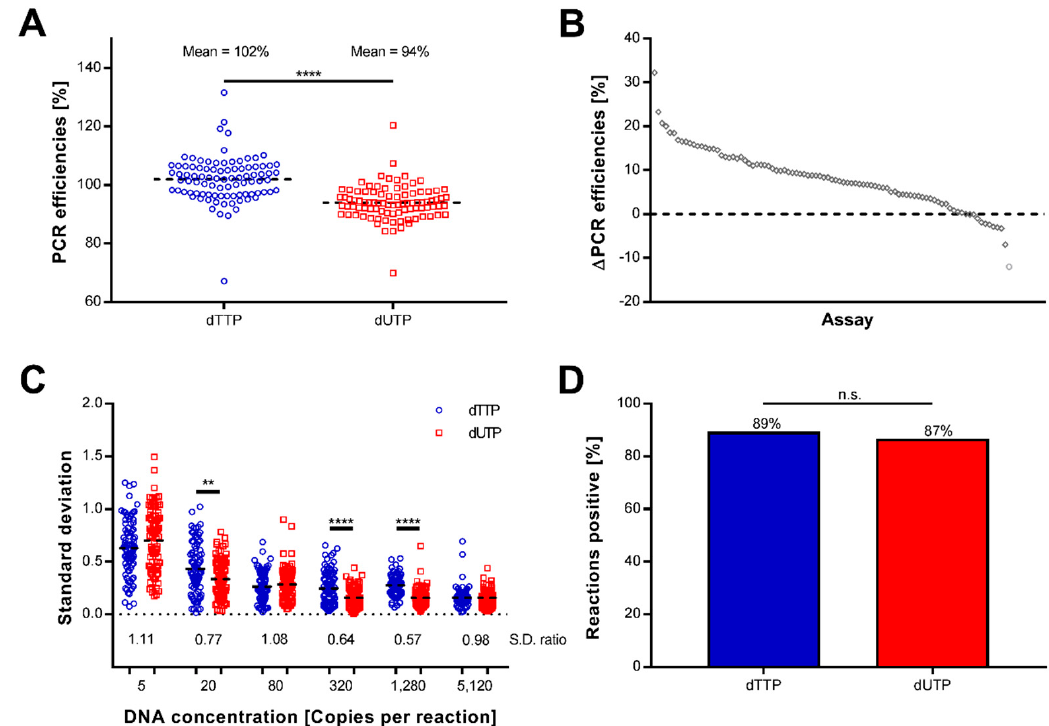
Figure 2. Targeted preamplification with deoxythymidine triphosphate (dTTP) and deoxyuridine triphosphate (dUTP). ( A ) Amplification efficiencies using dTTP and dUTP. Overall amplification efficiency of preamplification and quantitative real-time polymerase chain reaction (qPCR) was estimated using DNA standards. Each circle/square represents an individual assay. Dashed lines correspond to average polymerase chain reaction (PCR) efficiency. Difference in average PCR efficiency was tested using two-tailed Wilcoxon matched-pairs signed rank test ( n = 91 assays). **** p < 0.0001. ( B ) Amplification efficiency variability. Difference in PCR efficiencies (E) calculated as